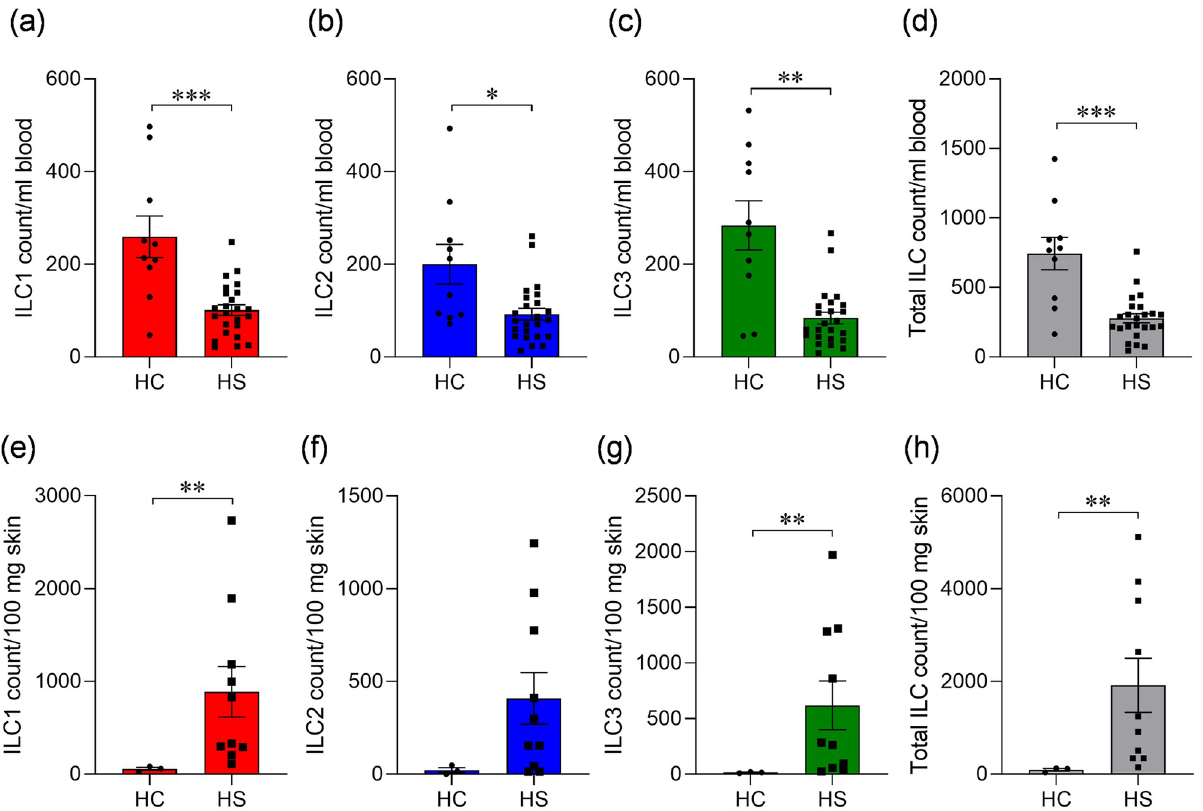
Fig 3. Absolute numbers of ILC in the blood and skin of hidradenitis suppurativa (HS) patients compared to healthy controls (HC). PBMC and skin-derived cells were analysed by flow cytometry for total numbers of ILC types 1 (ILC1), 2 (ILC2) and 3 (ILC3) and total ILC. ILC were defined as CD45 + CD127 + lineage-negative, with ILC1 defined as CD117 - CD161 + , ILC2 defined as CD294 + and ILC3 defined as CD117 + NKP44 +/- . Lineage ‘cocktail’ included antibodies specific for CD1a, CD3, CD11c, CD14, CD19, CD34, CD94, CD123, CD303, FC ε RI, TCR αβ and TCR γδ . Precision count beads were used to calculate cell numbers. (a-h) cell counts ( ± SEM) of ILC1, ILC2, ILC3 and total ILC per ml of blood in healthy controls (HC, n = 10) and HS (n = 24) patients (a-d), and per 100 mg of skin of healthy individuals (HC, n = 3) and lesional skin of HS patients (n = 10) (e-h). � P < 0.05, �� P < 0.01, ��� P < 0.001 using Mann-Whitney